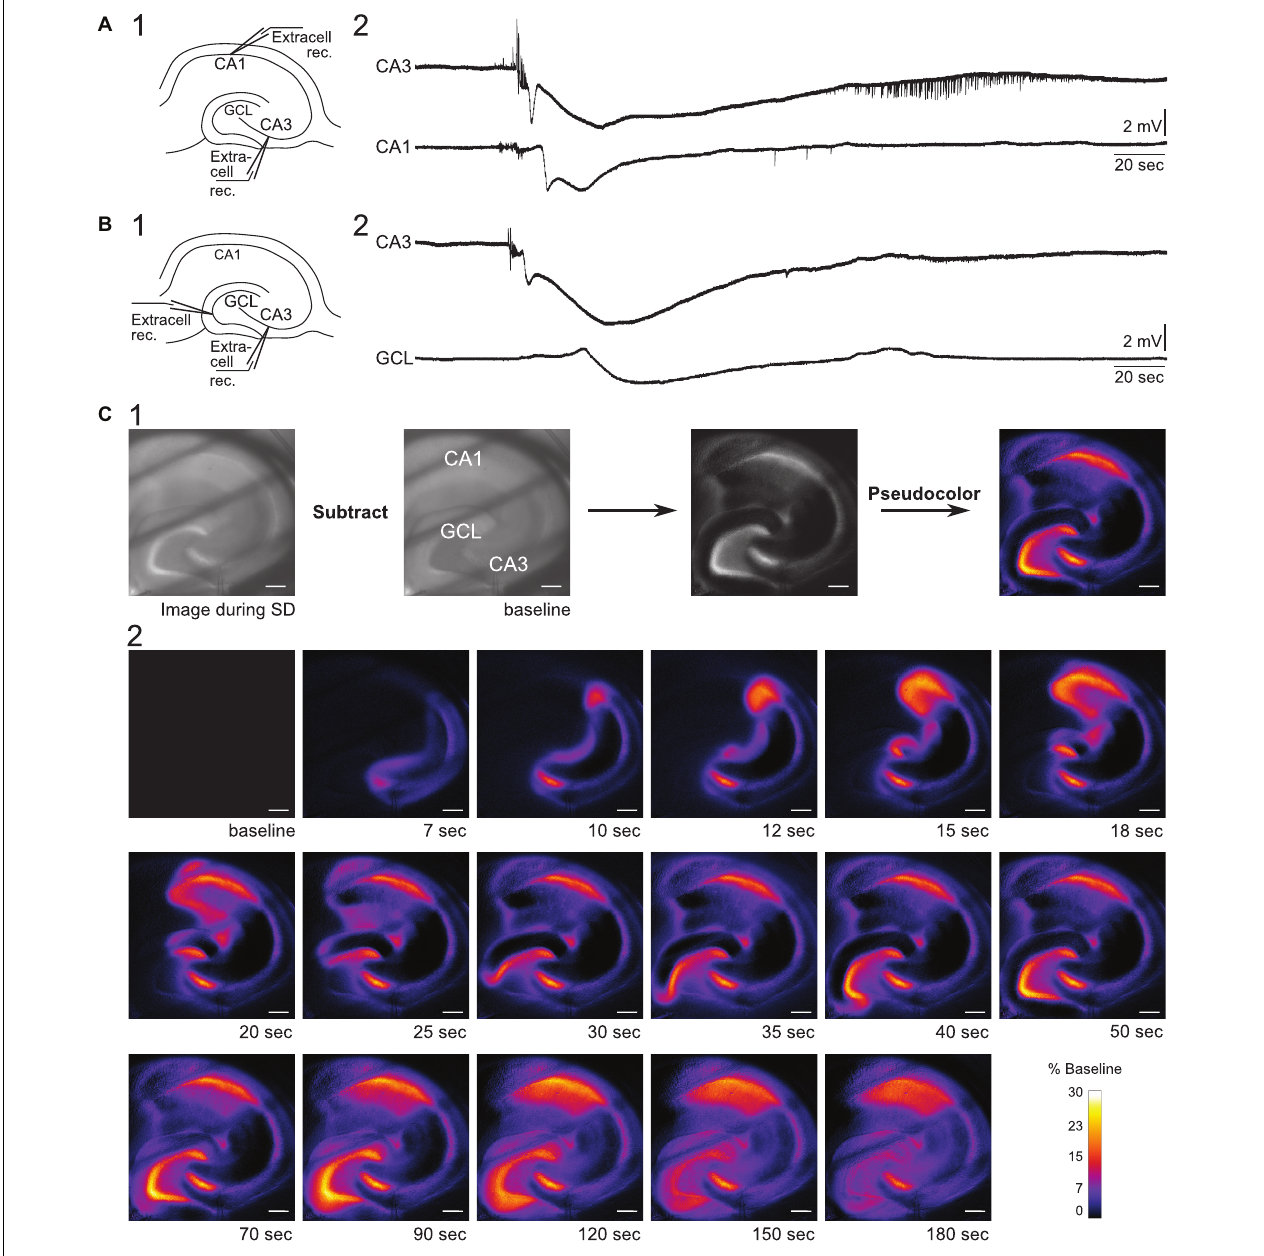
FIGURE 3 | Propagation of SD in mouse hippocampus. (A1) Schematic of dual field recordings in the CA3 and CA1. (A2) An SD propagated from CA3 to CA1. The electrical recordings show a significant delay between CA3 and CA1 DC shift, corresponding to the delay in the optical image in (C) . (B1) Schematic of dual field recordings in the CA1 and the GCL. (B2) An SD propagated from CA3 to the GCL with a delay. (C1) An SD was accompanied by a changed in the intrinsic optical signal. The difference in light transmission was calculated by subtracting a baseline image from the image acquired during SD. (C2) Consecutive images illustrate the propagation of an SD. Diagonal dark lines were from the mesh underneath the brain slice. GCL, granule cell layer. Scale bar, 200 µ m.